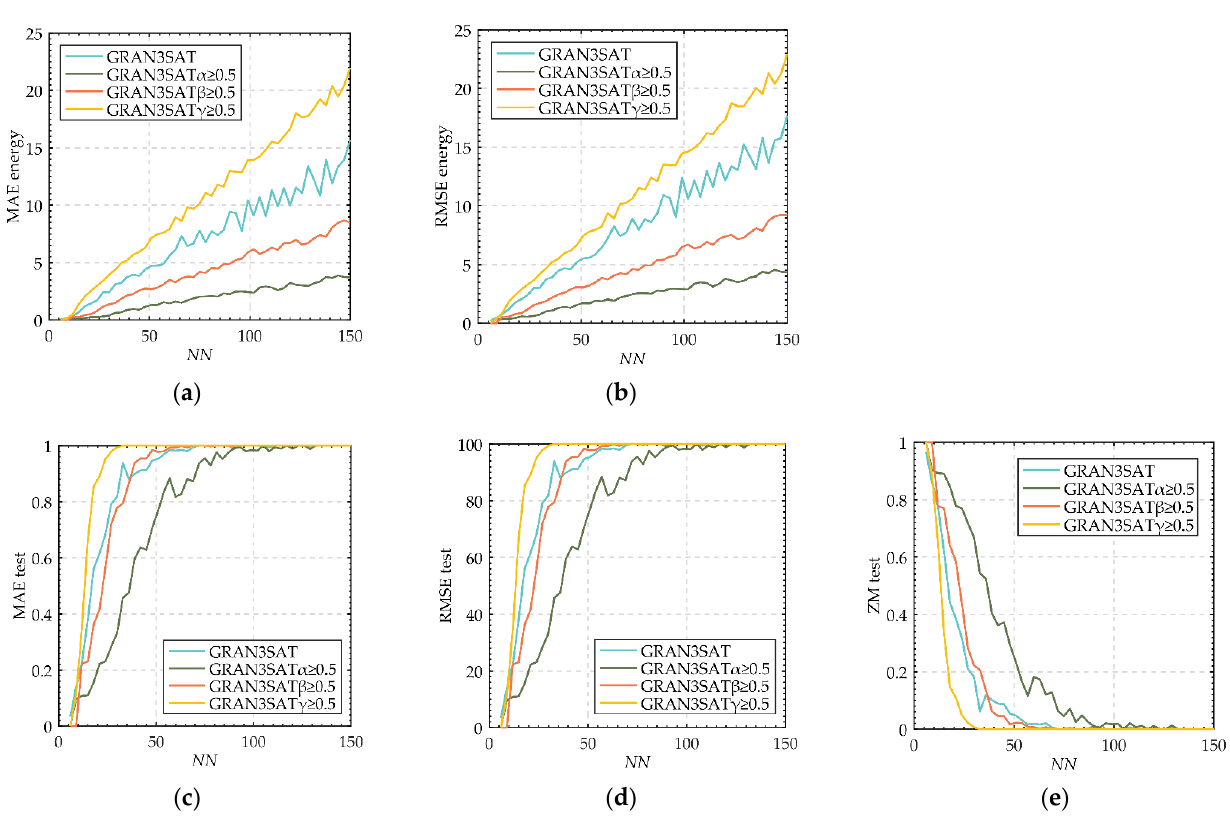
Figure 4. Error performance for ( a ) MAE energy , ( b ) RMSE energy , ( c ) MAE test , ( d ) RMSE test , and ( e ) ZM test . Table 7. The values of MAE energy and RMSE energy for different NN when MAE test =